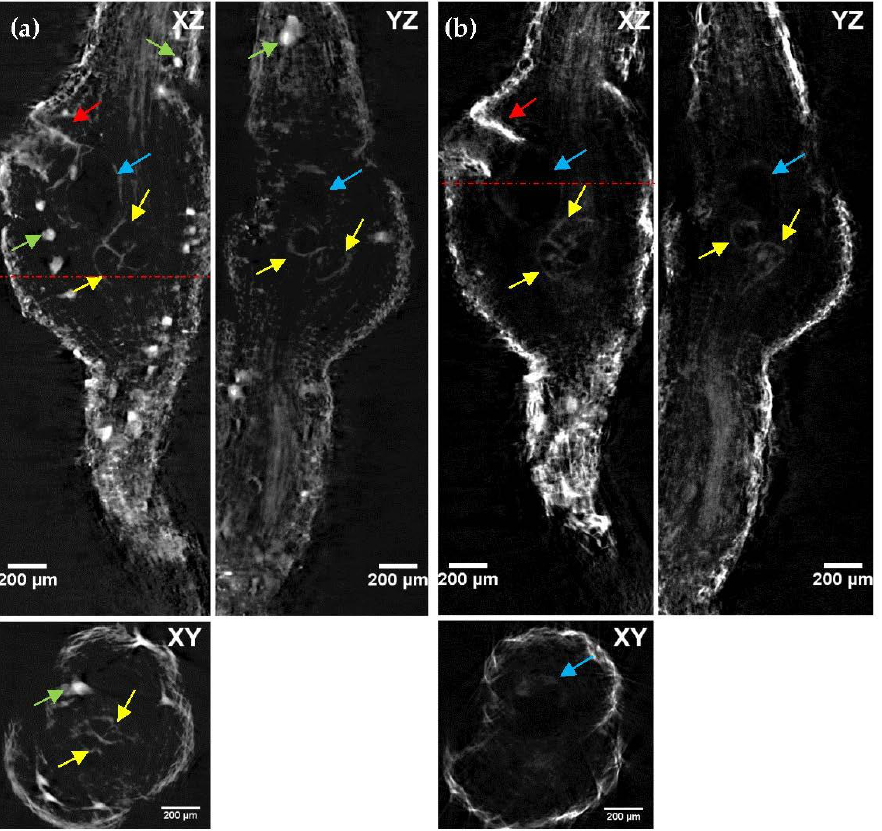
Figure 5. Optical projection tomography orthogonal views of a tomato root infected by M. incognita 6 weeks after nematode inoculation and cleared with 1-propanol–ECi acquired in ( a ) brightfield OPT mode and ( b ) fluorescence OPT mode. Giant cells (yellow arrows), adult female (blue arrows) and egg mass (red arrows) can be distinguished. In OPT brightfield mode, pigmented cells are also visible (green arrows). Scale bar: 200 µm.